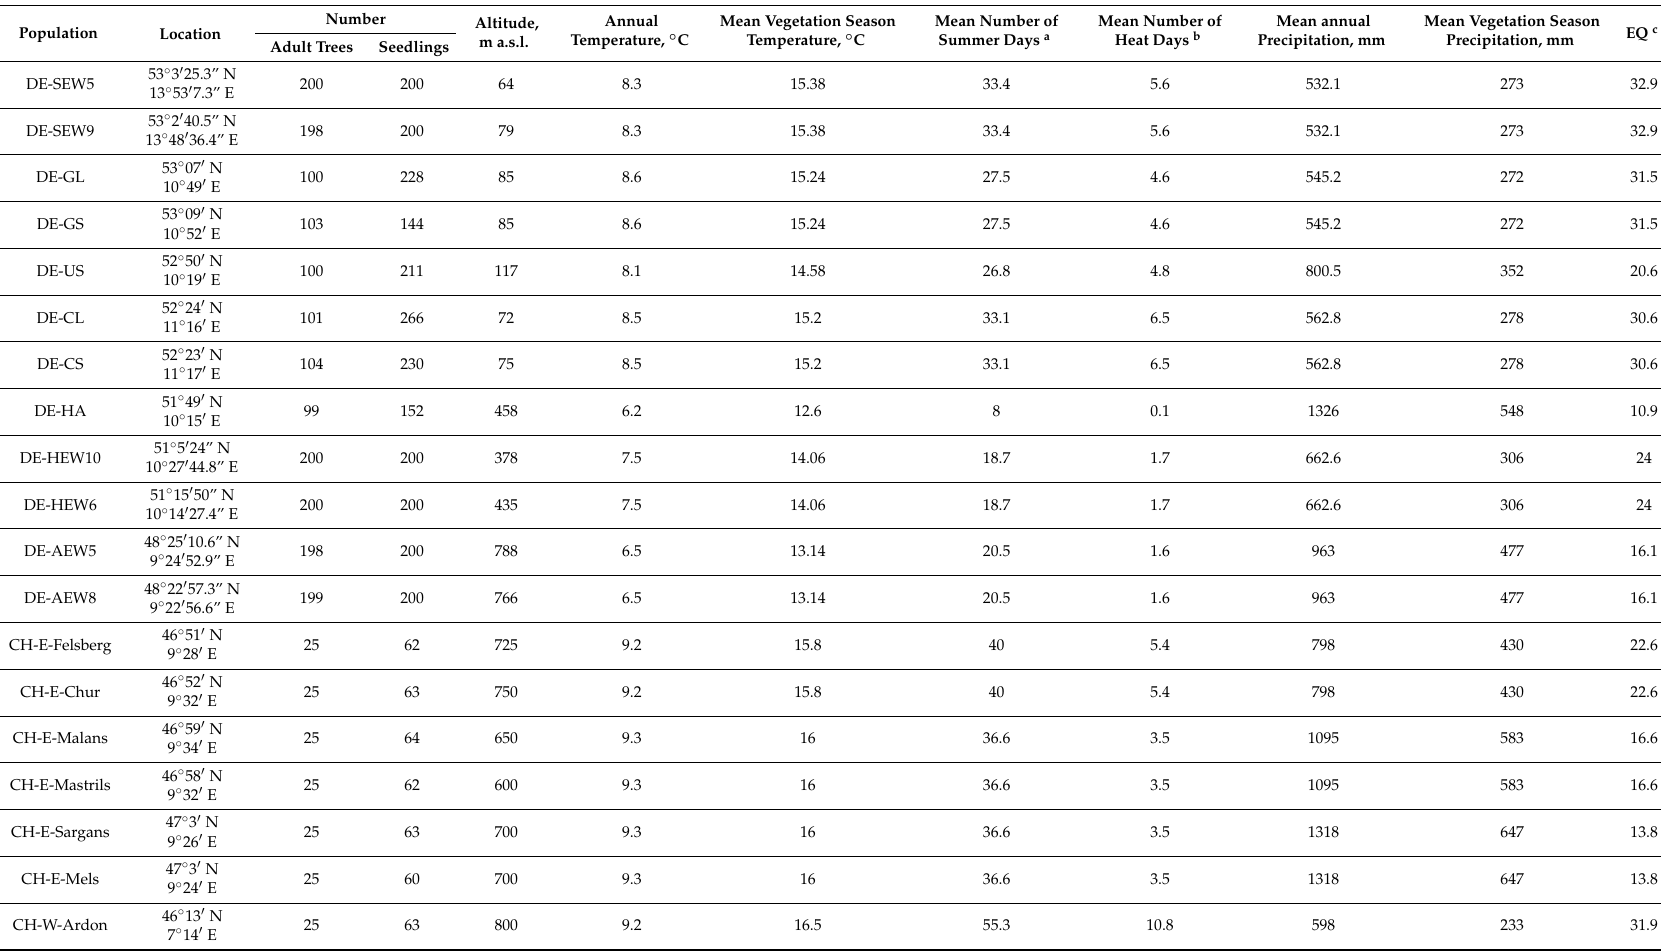
Table 1. Population name and location, number of sampled individuals and environmental variables for the studied beech